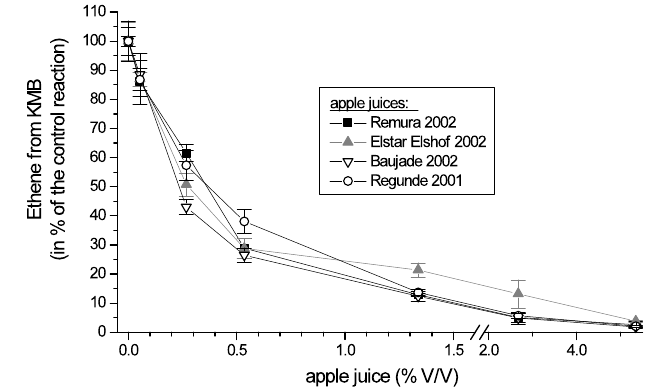
Fig. 2: Dose response plots of of apple juices determined in the X/XOD/ KMB test. The higher the antioxidant action of the apple juice, the lower is the amount of liberated ethylene from KMB. In a final aque- ous (phosphate buffered 100 mM, pH 7.4) reaction volume of 2.0 ml, xanthine 500 μM is converted into uric acid by 40 mU/ml XOD in gas tight sealed reaction tubes (12 ml). 1 ml gas aliquots of their headspace were quantified by GC. Ethylene is liberated from KMB via the superoxide assisted Fenton reaction, producing OH radicals. In the basic reaction without apple juice the amount of formed ethene from KMB was approx. 7 ± 0.35 nmol (=100%), accumulated in 30 min at 37